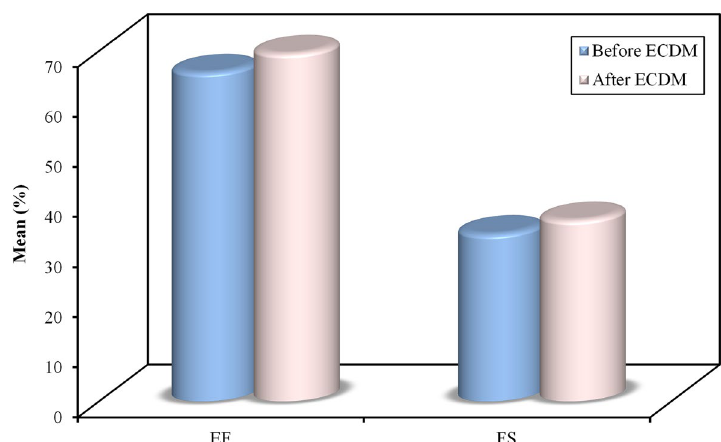
Fig. 2 Compression between the mean of EF and FS before and after ECDM in patients with birth weight > 1500 g